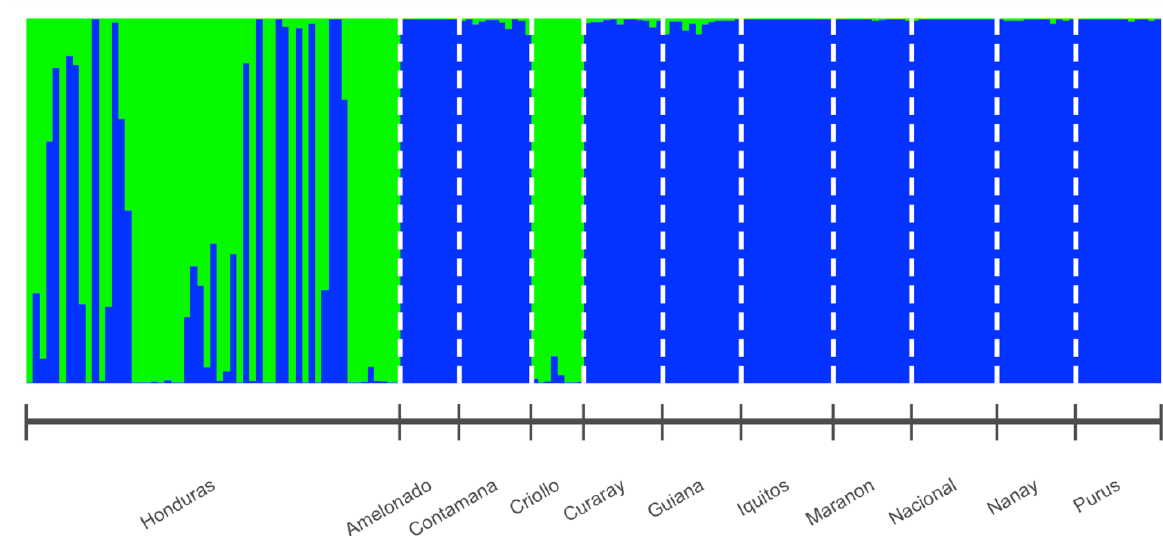
Figure 4. Population structure of Theobroma cacao L. of the “Complete” dataset based on 16 SSR markers, using the best assignment result retrieved according to the Evanno method (K = 2) [49]. Each individual sample is represented by a vertical line divided into K colored segments that represent the membership fraction for each cluster. The bar line under the plot represents the Honduras samples and the ten genetic groups identified by Motamayor et al. [17].